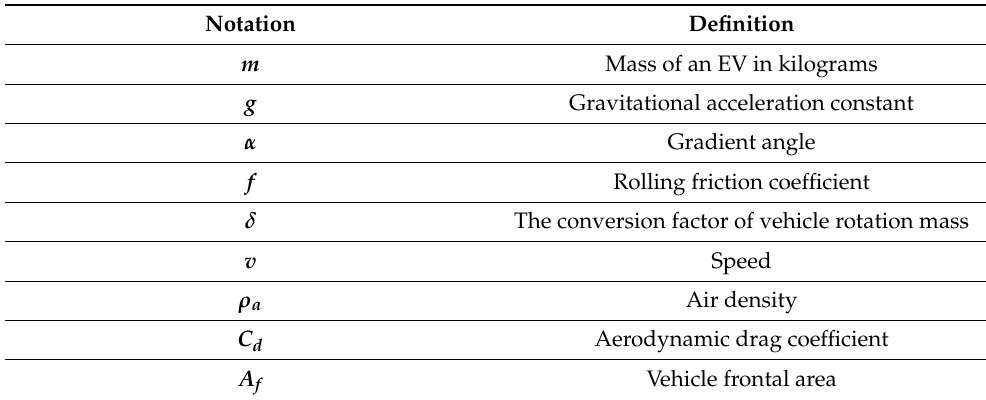
Table 1. Notation to calculate